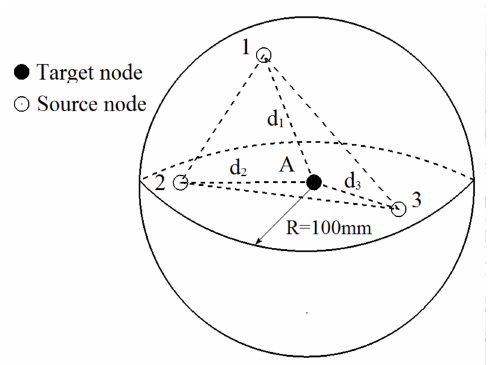
Figure 1. Sketch of data transfer (Number of nodes N = 3, Maximum distance R = 100 mm).